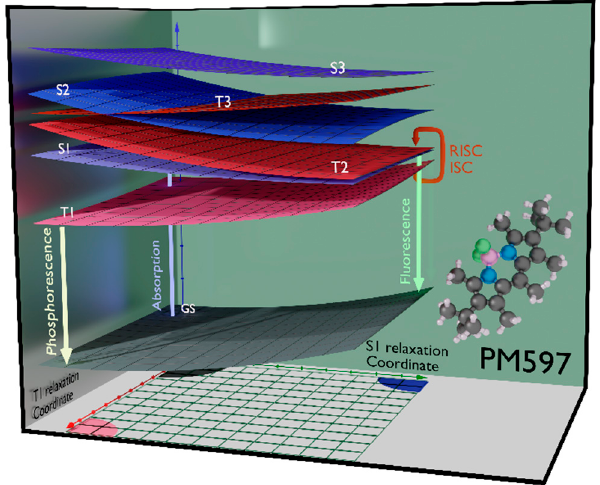
Figure 4. Schematic potential energy surface of representative PM597 interpolated along the T 1 and S 1 relaxation coordinates. The interpolation is performed assuming a harmonic potential between the ground-state optimized geometry and either the S 1 or T 1 minimum geometry. Only the energies of the electronic states at the ground state, T 1 and S 1 optimized geometries are computed. Crucially, the close proximity of the S 1 and T 2 states at the S 1 minimum is clearly visible at the S 1 minimum energy geometry.